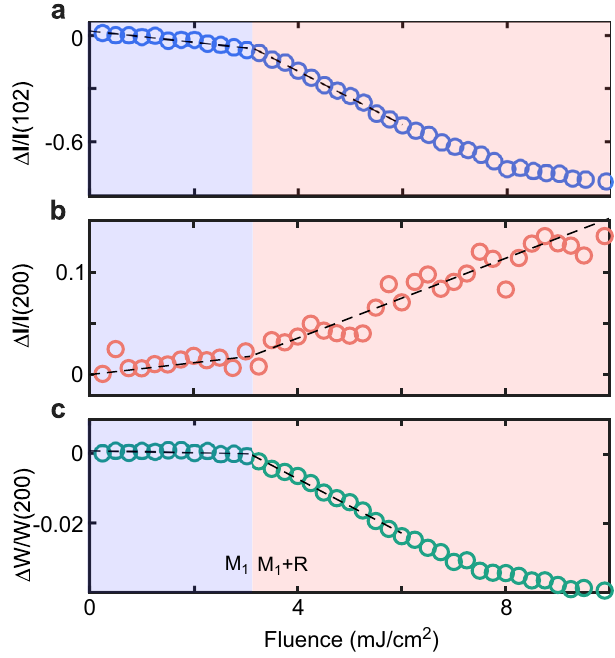
Fig. 4 | Measurements of the laser fl uence. Fluence dependence of the changes measured at t =10ps after photoexcitation for 102 peak intensity ( a ), 200 peak intensity ( b ), and 200 peak width ( c ). Dashed lines are a guide to the